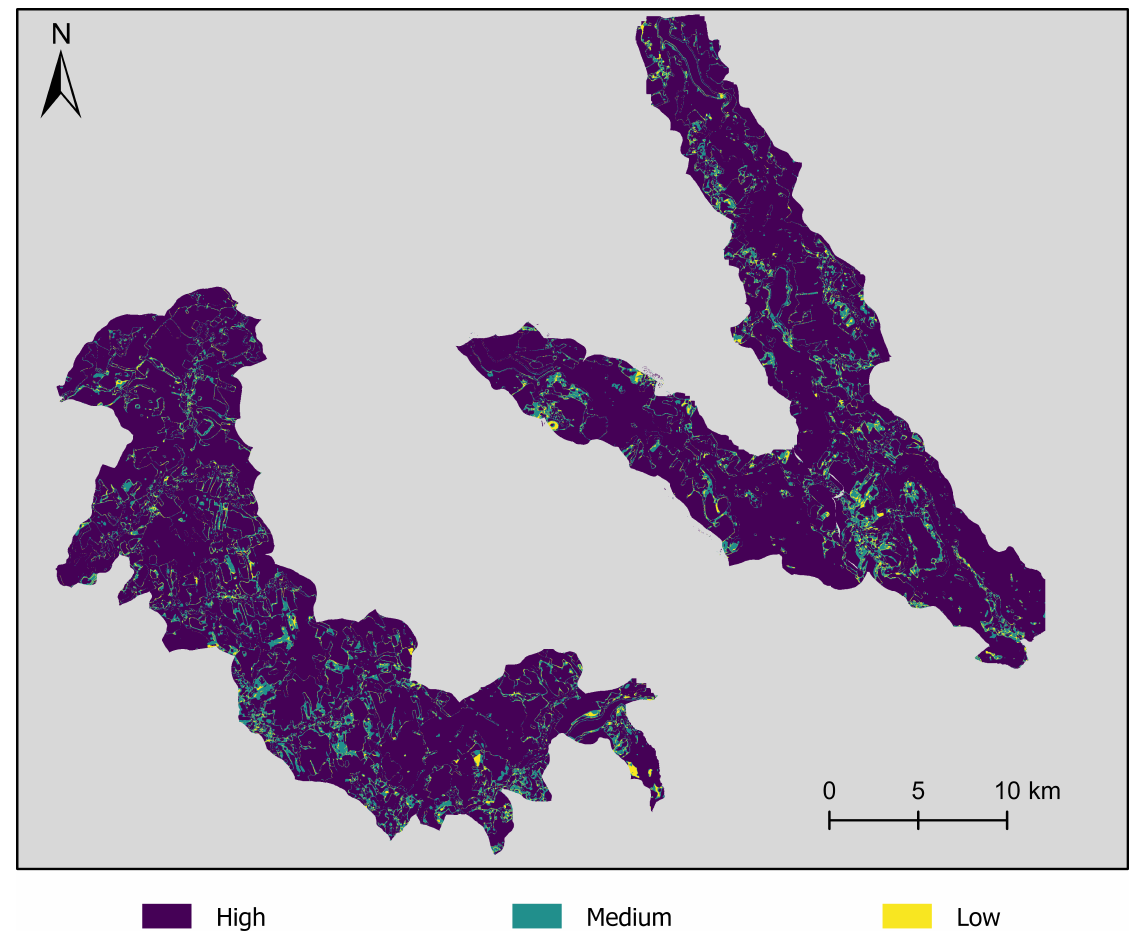
Figure 13. Visualization of the confidence with respect to the classification result of the LSTM F . The confidence is calculated as the voting of the individual predictions of the six sequences. A unison vote implies high confidence (dark blue), an absolute majority vote implies medium confidence (green), and no majority implies low confidence